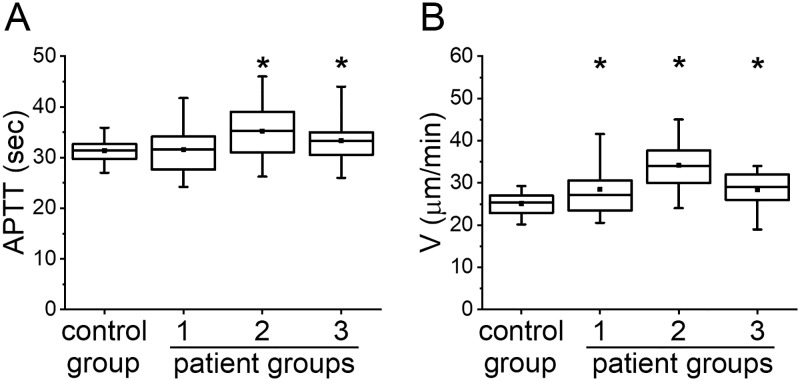
APTT vs TD parameters before heparin treatment.(A) APTT and (B) V in TD before heparin treatment in groups: healthy volunteers (control group), group 1, group 2 and group 3. The box plots indicate the following parameters: the mean value (the dot inside the box), the median (the horizontal line inside the box), the 25th and 75th percentiles (the bottom and top of the box, respectively) and the 5th and 95th percentiles (the ends of the whiskers). * indicates a significant difference from healthy volunteers group (p<0.01, Mann-Whitney test).